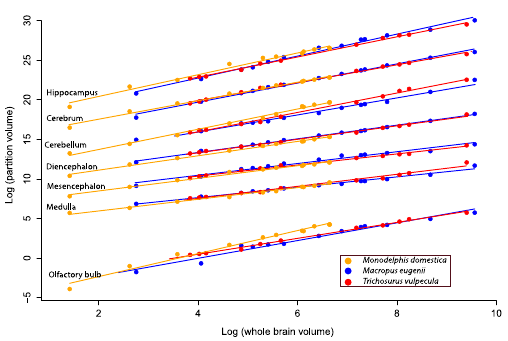
Figure 4. Joint plot of log partition volume against log brain volume (in mm 3 ), with linear regression lines. Artificial intercepts (arbitrarily raising the slopes so they are not superimposed on the image) were added to allow separate viewing of the regression lines as established by 8 . The regression lines in this plot were cropped in Adobe